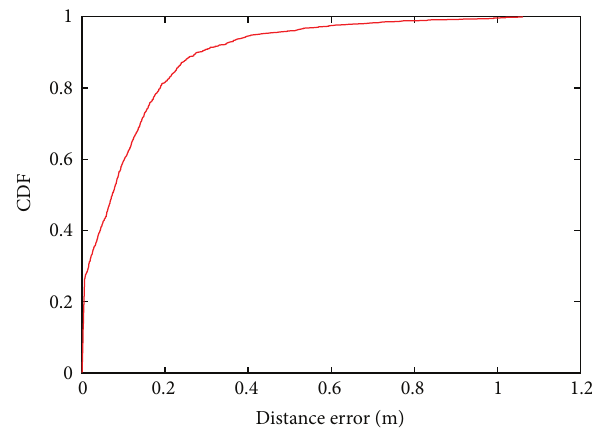
Figure 4: Cumulative distribution function of the distance error between the actual locations and the corresponding approximated